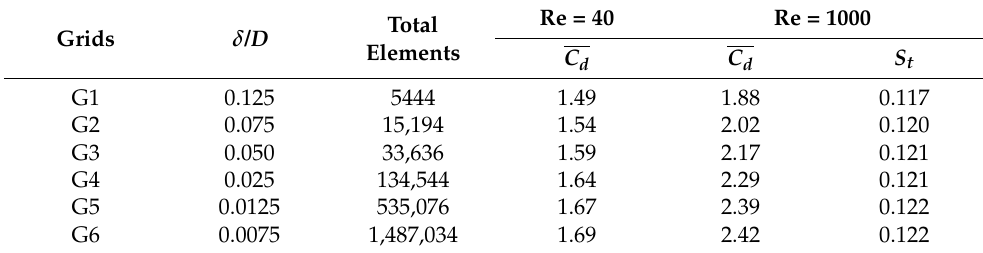
Table 3. Comparison of C d and S t of the flow around a square cylinder under different grid resolutions. Re = 40 Re = 1000 Total Grids δ / D Elements C d C d S